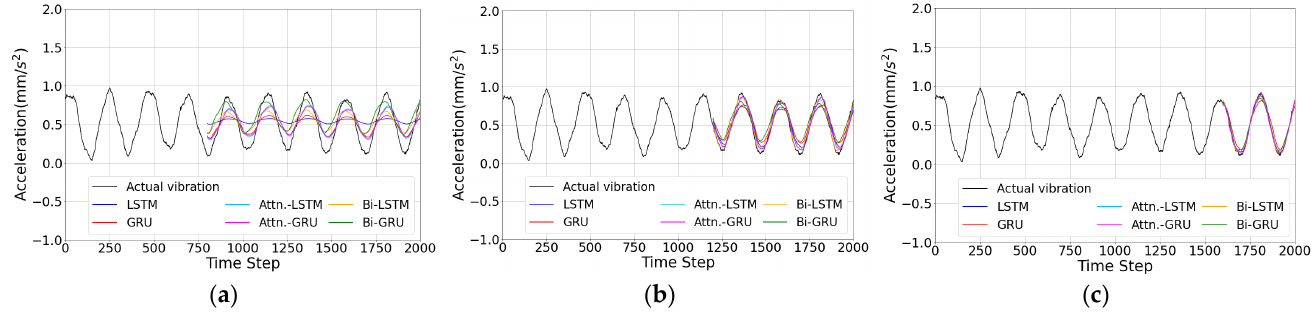
Figure 9. Waveforms of the vibrations predicted from the normal vibration: ( a ) 40%, ( b ) 60% ( c ) 80% segments of training data.